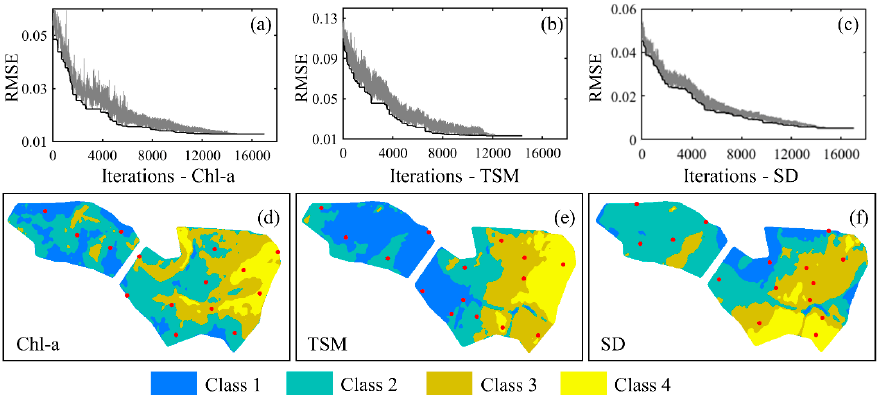
Figure 7. Minimize the objective function curve during SSA and Chl-a, TSM, and SD optimal sampling points ( a – f ).